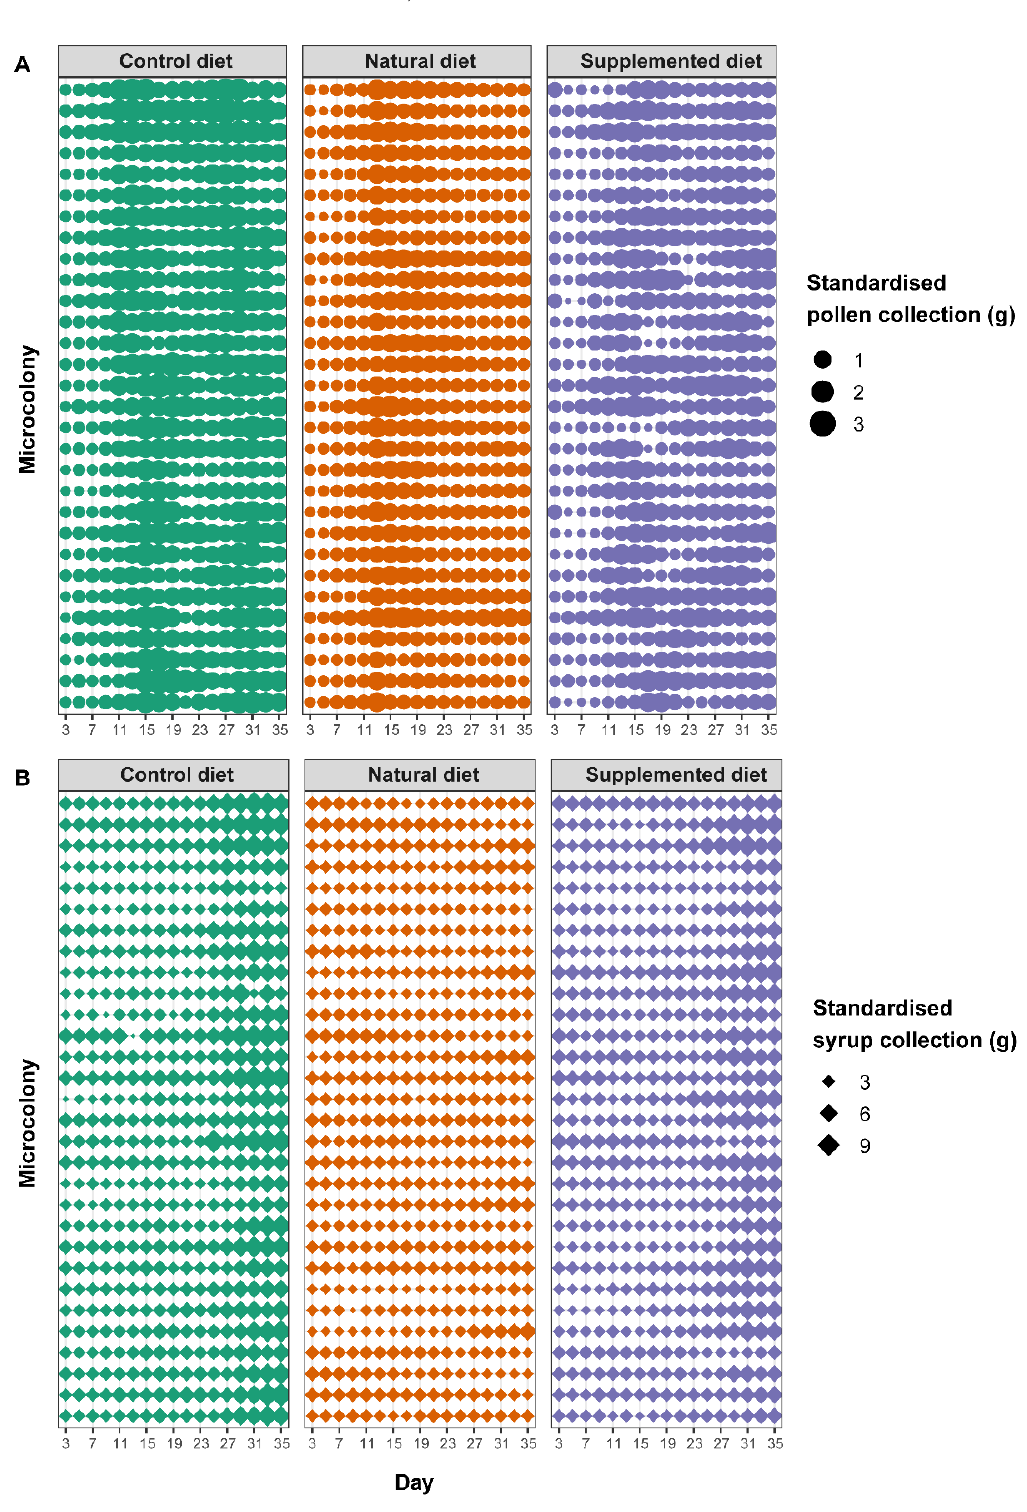
Figure 2. Standardised food collection in microcolonies over time. Each horizontal line represents the collection values for a single microcolony over time. The thickness of the dots or diamonds indicates the mass of collected ( A ) pollen and ( B ) syrup, respectively, per g of bee on that day.